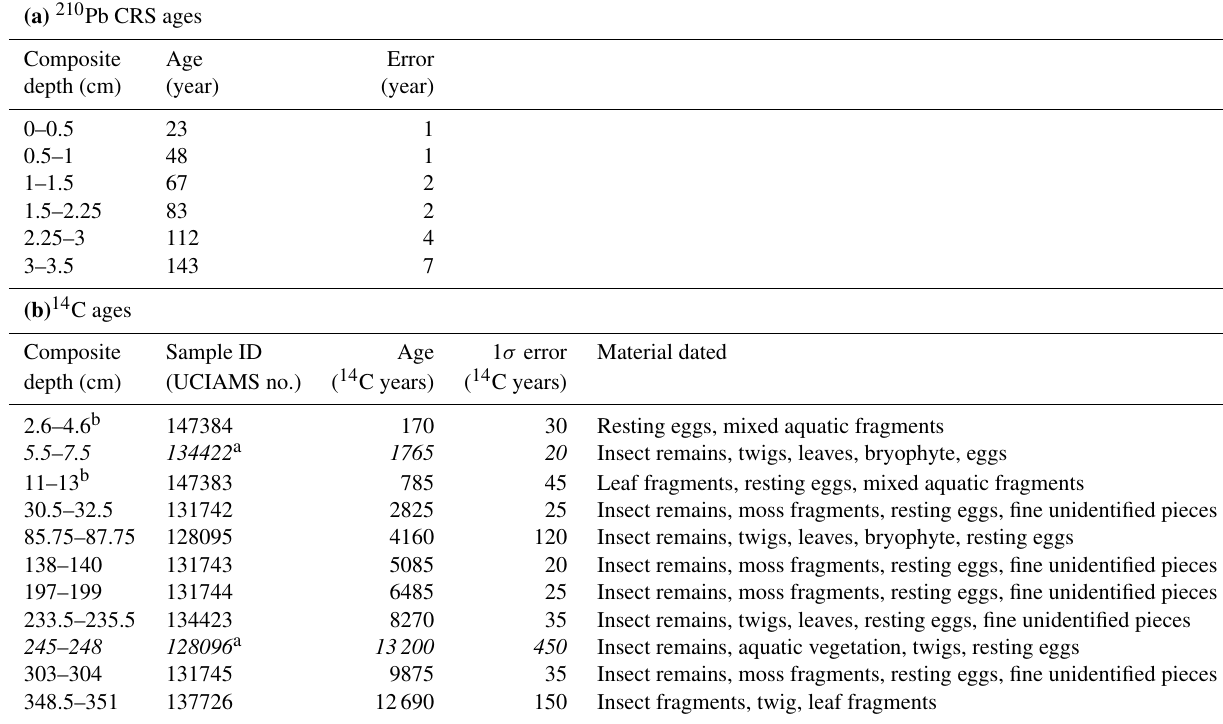
Table 1. Radiometric ages produced from Cascade Lake sediment cores (from Steen, 2016): (a) 210 Pb ages calculated using the Constant Rate of Supply model (CRS; Appleby and Oldfield, 1978); (b) 14 C ages with ± 1 σ errors. Ages are reported to the nearest whole year ( 210 Pb) or 5 years ( 14 C). Italicised rows with sample IDs with a : 14 C ages rejected as outliers; b : samples from surface core CASC-4B; all other samples are from